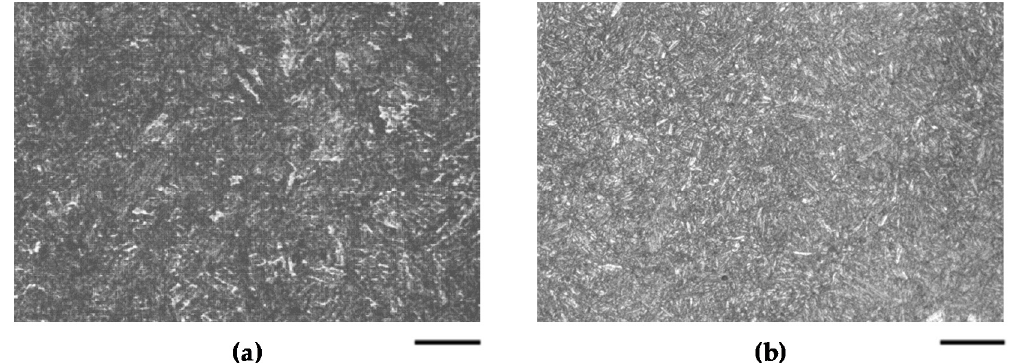
Figure 8. Microstructure of the axle area of the 42CrMo4 steel grade after heat ‐ treating the hot ‐ forged ( a ) and NSF ( b ) components. Scale bar: 30 µ m. ( a ) and NSF ( b ) components. Scale bar: 30 μ m.